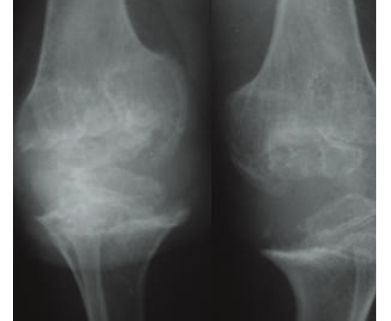
Fig. 5. Proband’s knee X-rays (AP) show significant metaphyseal irregularities (flaring and splaying) and small